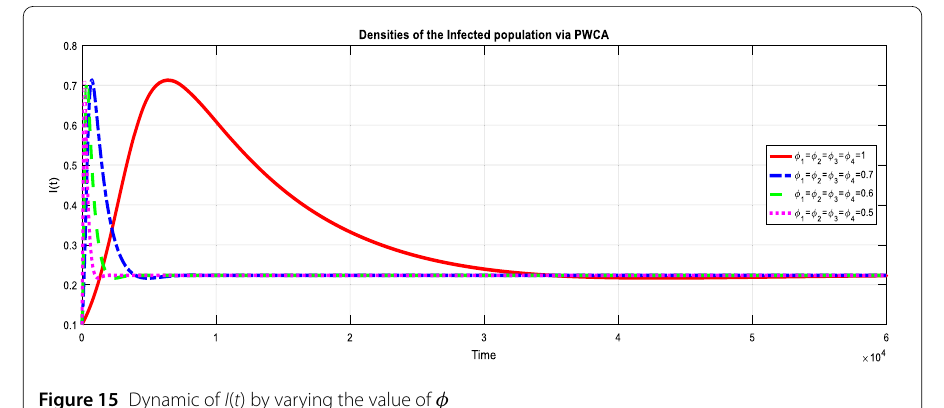
Figure 15 Dynamic of I ( t ) by varying the value of φ